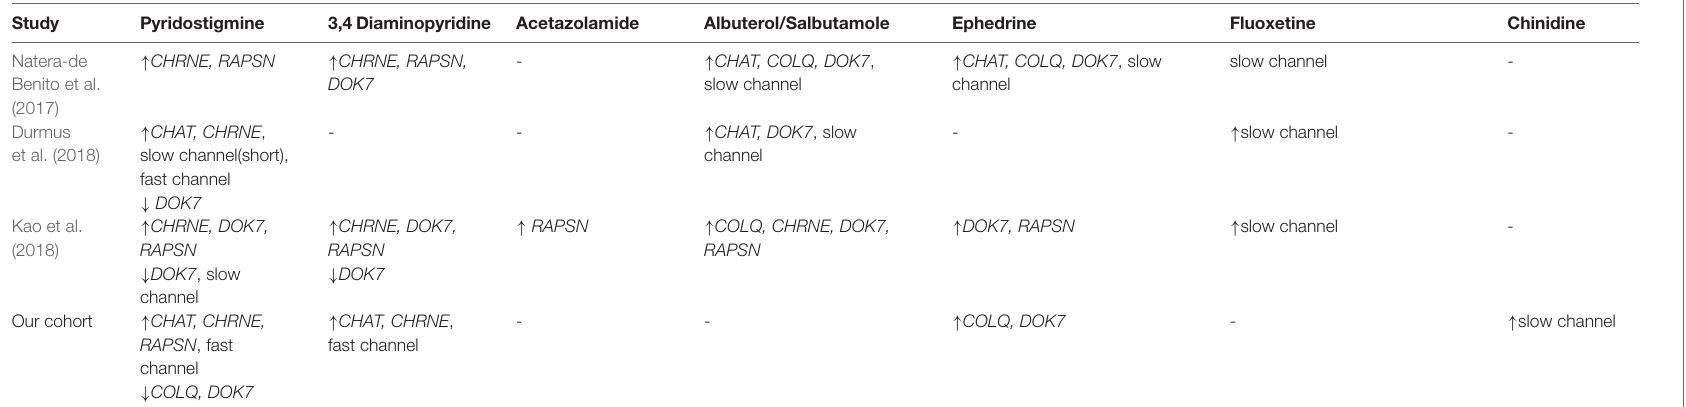
TABLE 3B | Response to applied therapy in two adult/one mixed and in our